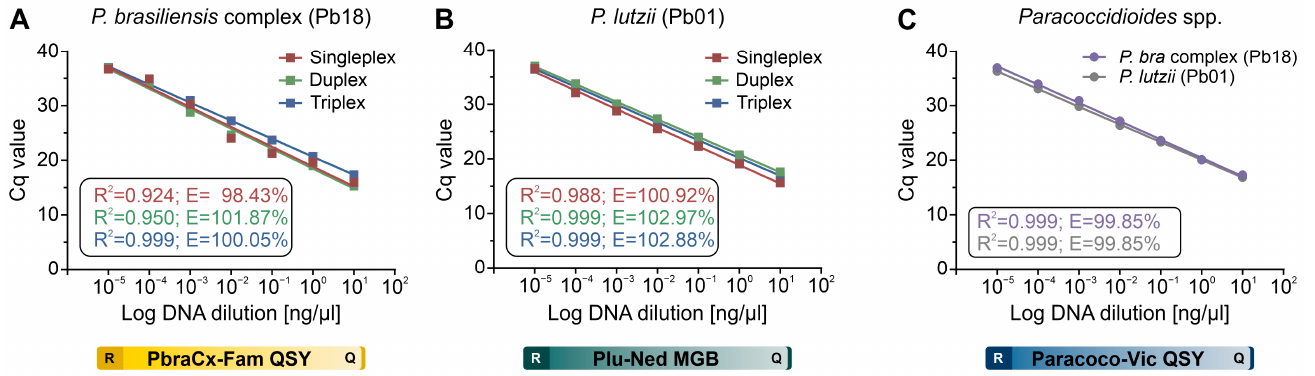
Figure 2. Standard curves were constructed for ( A ) P. brasiliensis probe (Pb18 DNA, PbraCx-Fam), ( B ) P. lutzii probe (Pb01 DNA, Plu-Ned), and ( C ) Paracoccidioides species probe (Pb18 or Pb01 DNAs, Paracoco-Vic) under a singleplex-probe (red line), a duplex-probe (green line), or a triplex-probe qPCR assay (blue line), showing comparable efficiencies and that the qPCR settings are multiplex- compatible. The results are typical of two separate experiments. R: reporter; Q: quencher.